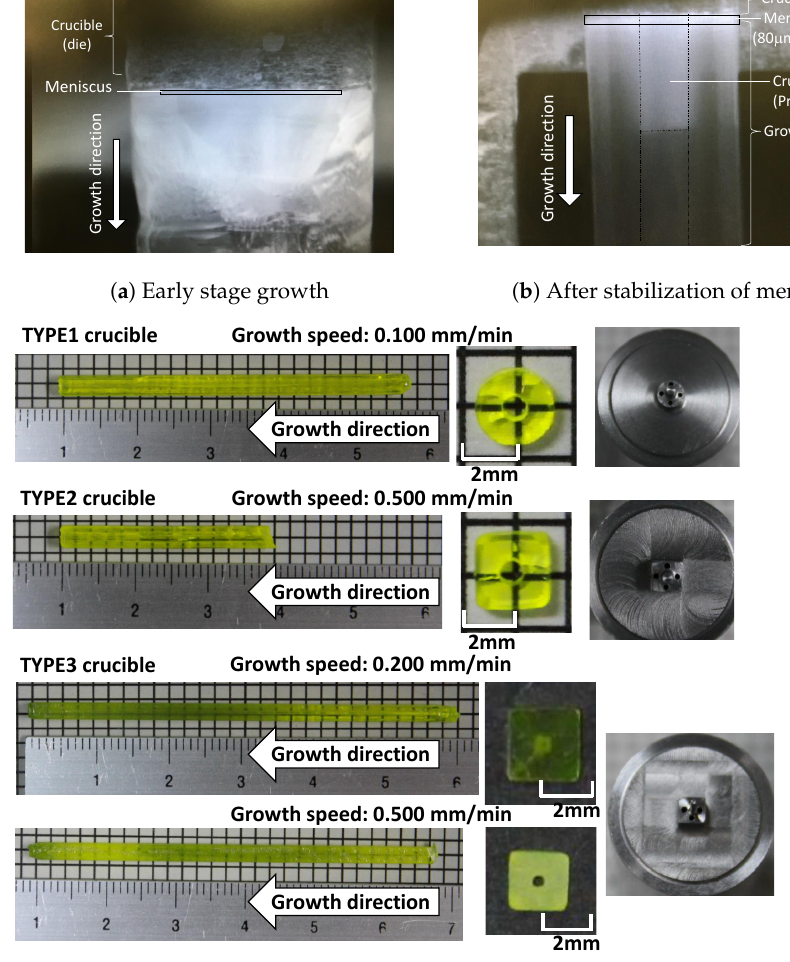
Figure 3. ( a , b ) Liquid–solid interface during crystal growth and ( c ) tube-shaped crystals grown by three types of Mo